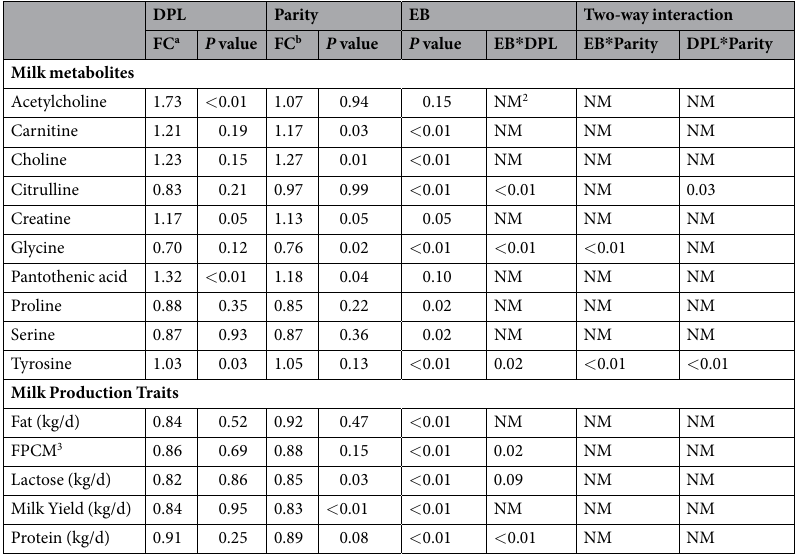
Table 2. The effect of dry period length (DPL), parity and energy balance (EB), on 10 milk metabolites and 5 milk production traits obtained through partial least squares analysis in lactation week 7. These 15 variables had a relatively high VIP score 1 in week 7. a Fold change in the metabolite concentration (DPL 0/30). b Fold change in the metabolite concentration (parity 2/3). 1 Variable importance in projection score in partial least